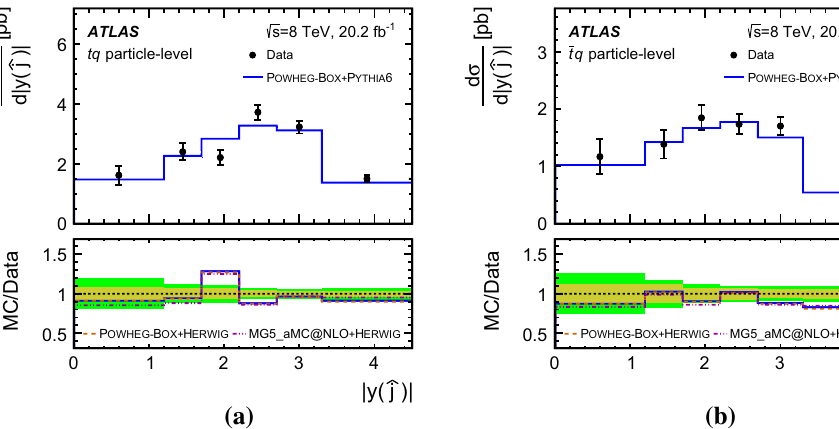
data points denote the total uncertainty. The inner ( yellow ) band in the bottom part of each figure represents the statistical uncertainty of the measurement, and the outer ( green ) band the total uncertainty